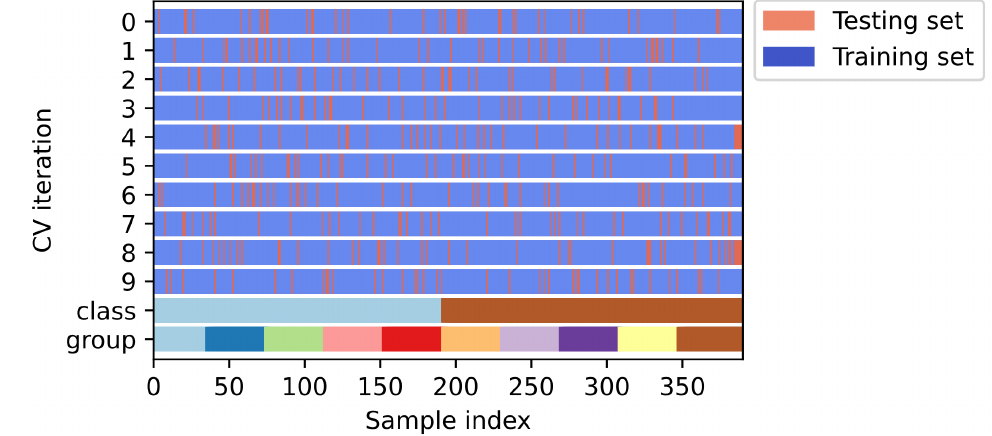
Figure 7. The composition structure of the cross-validation dataset.